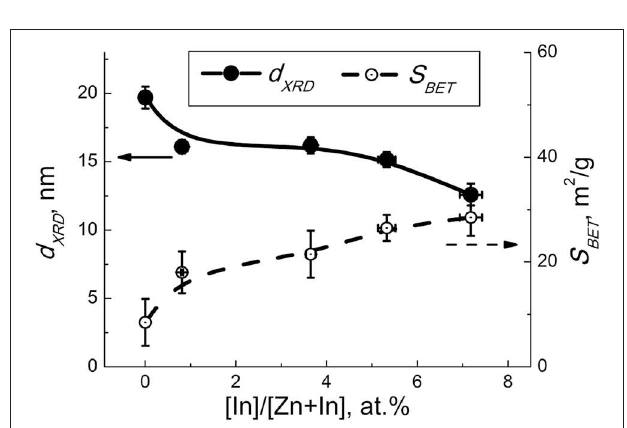
FIGURE 2 | Mean particle size of ZnO ( d XRD , solid lines) and BET area ( S BET , dashed lines) in relation to the concentration of indium oxide.